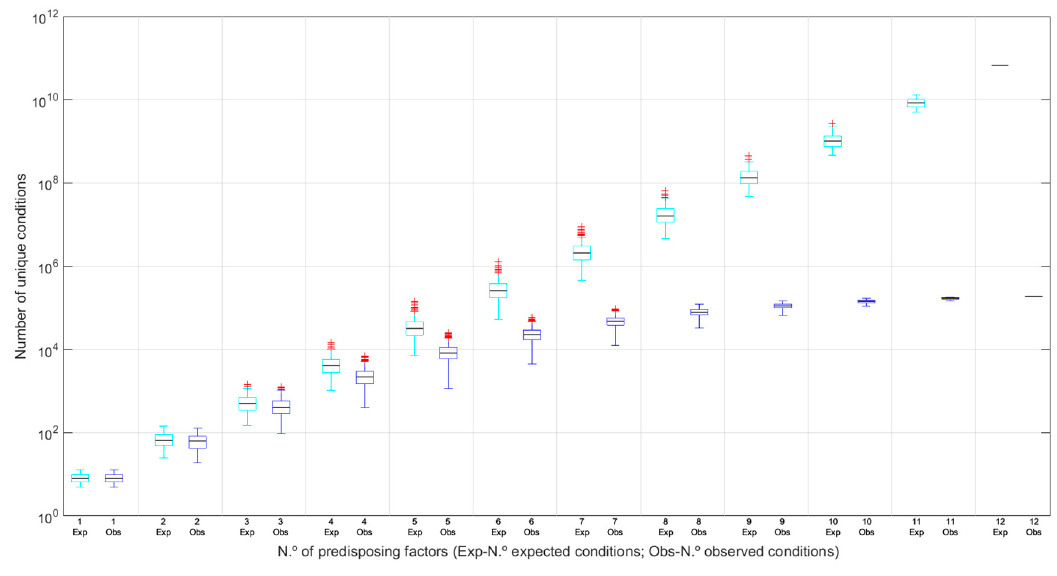
Figure 8. Expected and observed number of unique terrain conditions for different numbers of predisposing factors used in the susceptibility models.